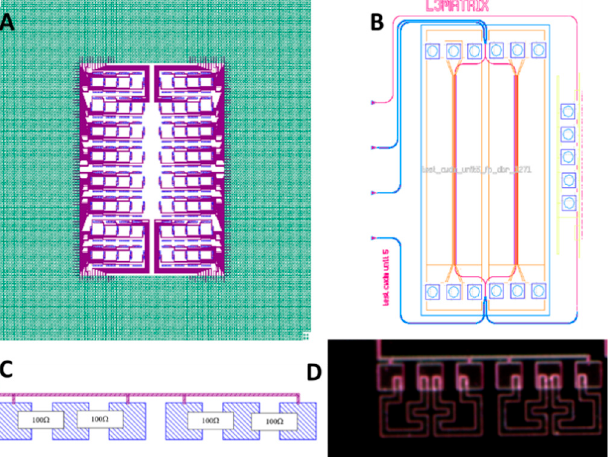
Figure 19. Chiplet mimic interposer ( A ) showing the SiP assembly area in purple and the package assembly area in green. A single interposer cell is shown in ( B ) with the bumps over the SiP transmit cell. The 100-ohm termination design for the modulator is shown in ( C ); the resulting silicon is in ( D ).